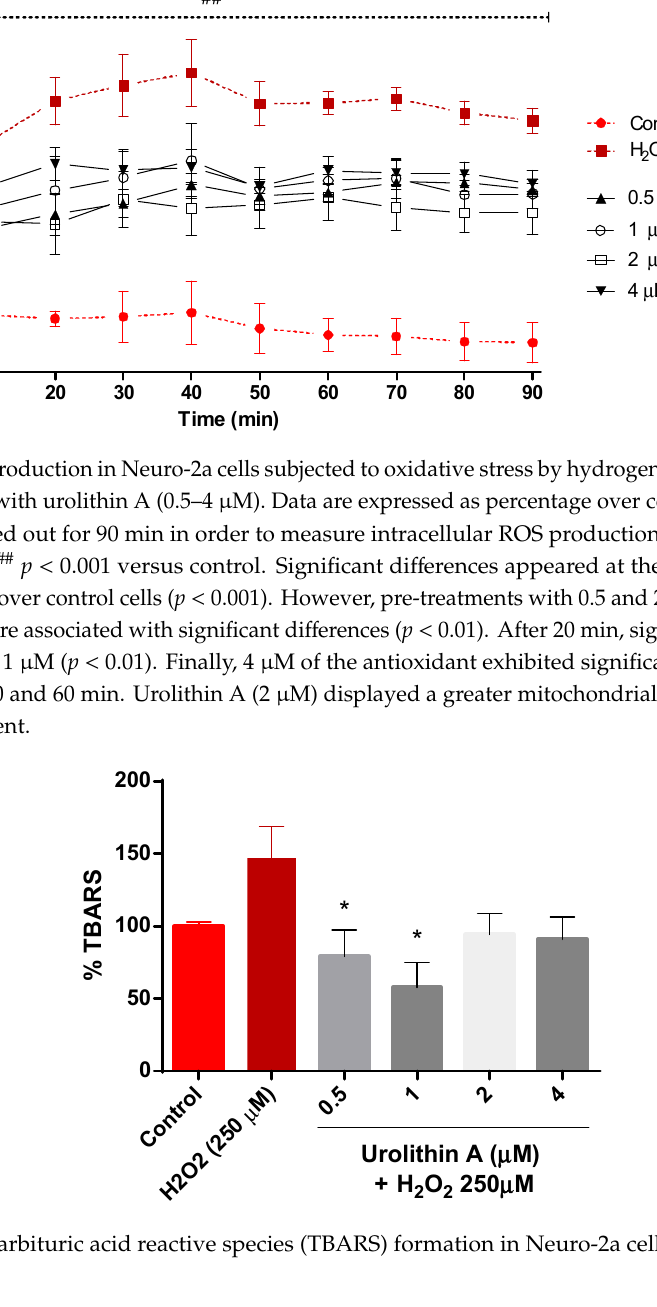
Figure 4. Thiobarbituric acid reactive species (TBARS) formation in Neuro-2a cells. Note: * p < 0.05 versus H 2 O 2 .